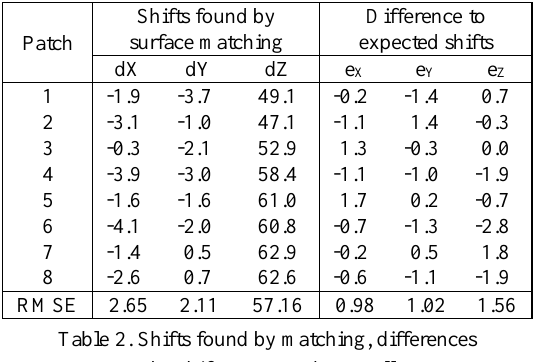
Table 2. Shifts found by matching,